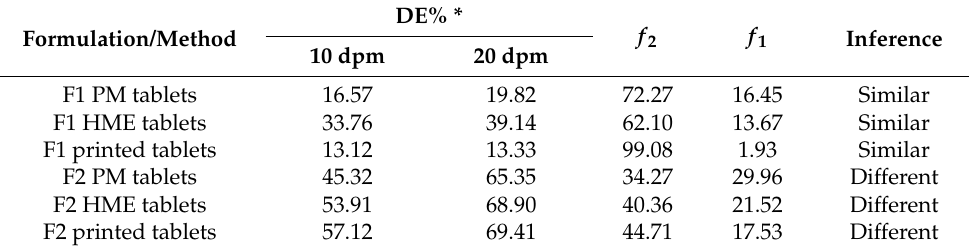
Figure 1. Dissolution profiles of F1 and F2 tablets prepared by the three manufacturing methods (PM, HME and 3D-printed) measured under dipping rates of 10 dpm and 20 dpm, and added ionic strengths of 0.2 M and 0.4 M. Error bars indicate SD values. For the clarity of figures, error bars were drawn from just one side. Table 3. Parameters extracted from dissolution profiles, including DE% values and similarity ( f 2 ) and difference ( f 1 ) factors of the dissolution profiles of the various tablets dissolved at different dipping